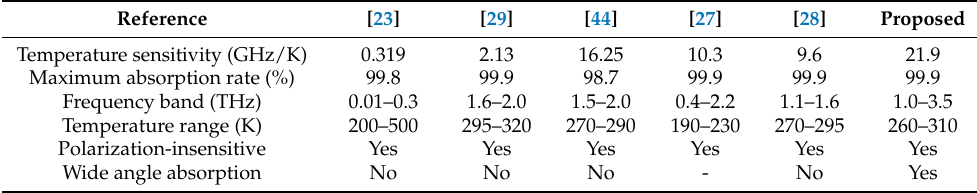
Table 1. Compare the previously reported sensor with the proposed sensor.